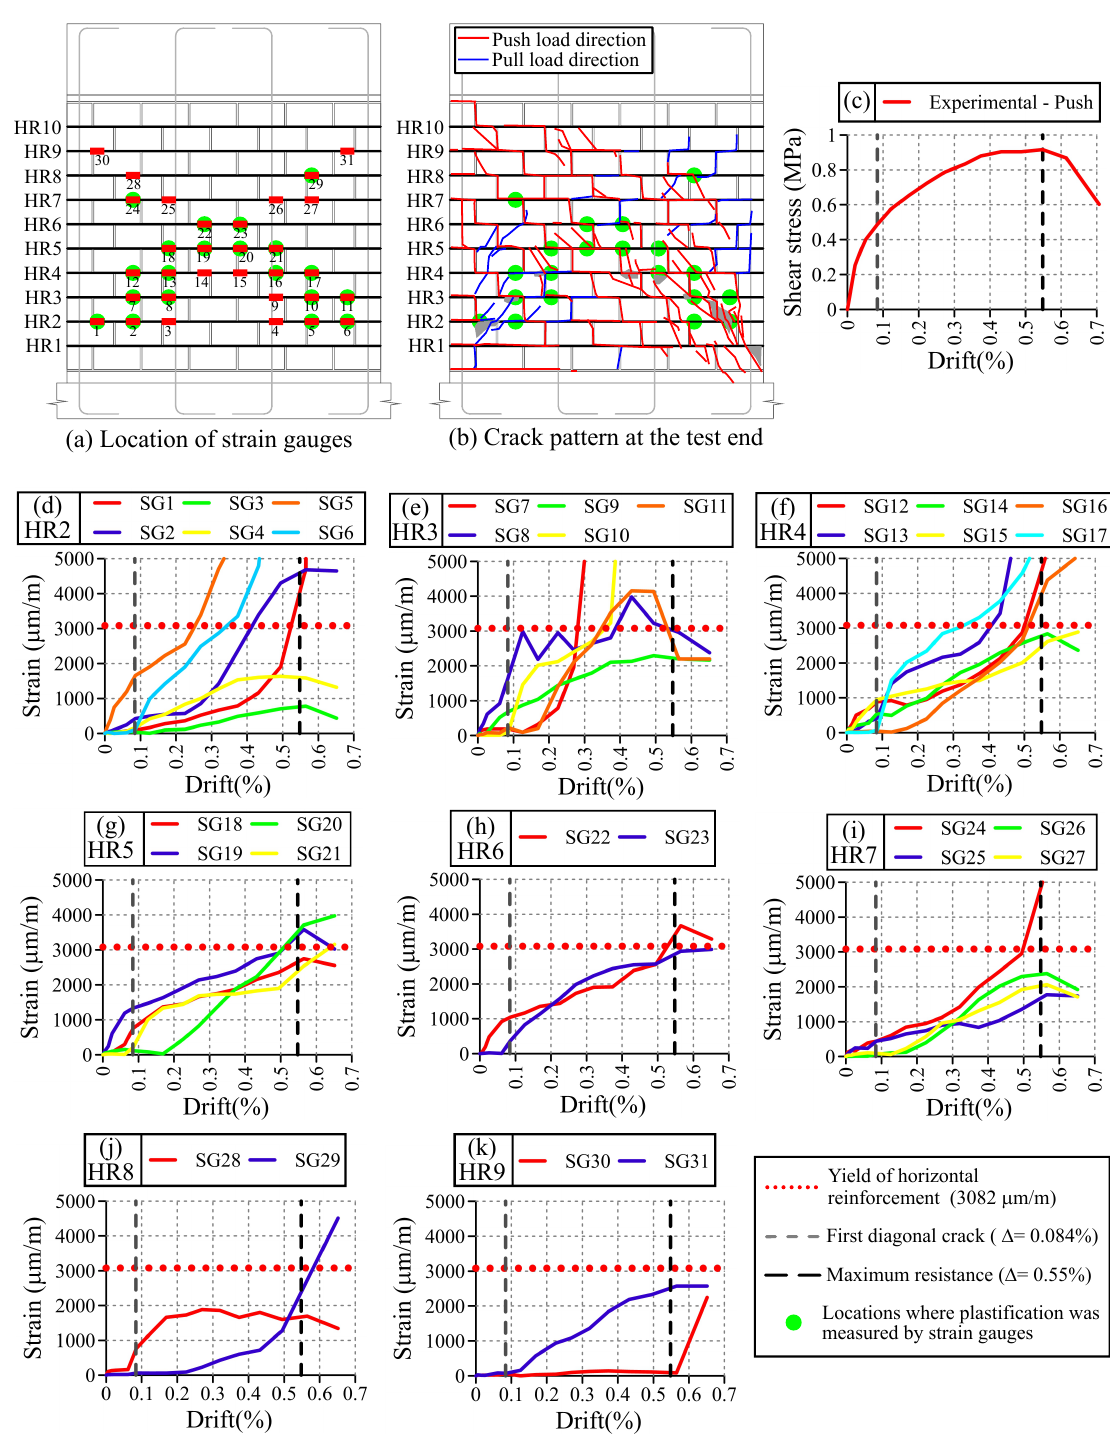
Figure 9. Strain gauge schemes and measurements for the wall HCBW1-A: ( a ) location of strain gauges, ( b ) crack pattern at the test end, ( c ) envelope curve in the push load direction; Envelope curves of the strain gauges in the push load direction at: ( d ) HR2, ( e ) HR3, ( f ) HR4, ( g ) HR5, ( h ) HR6, ( i ) HR7, ( j ) HR8, and ( k )